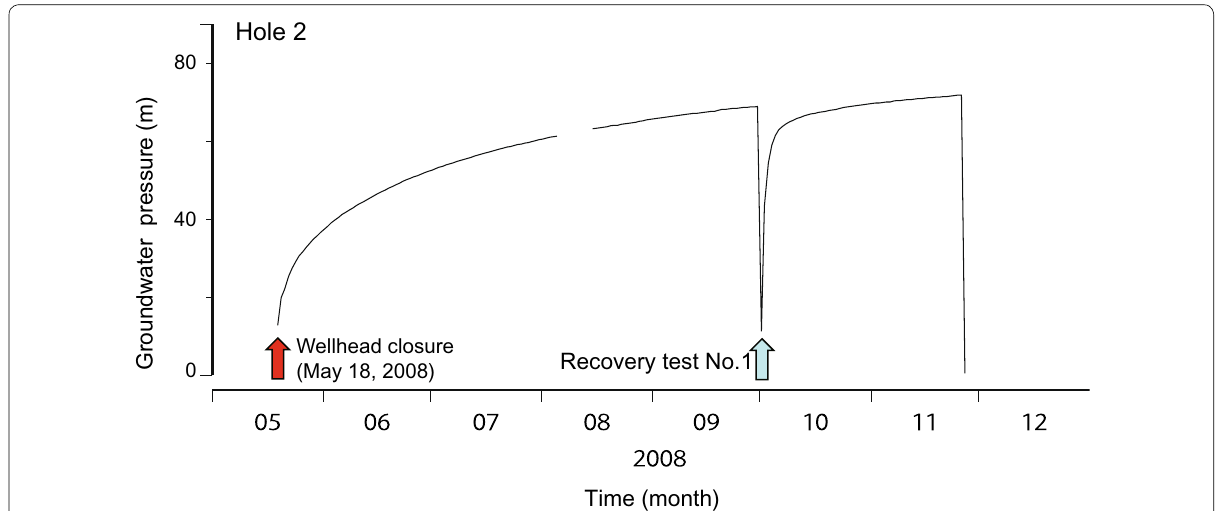
Fig. 5 Daily groundwater pressure data from 2008 at Hole 2. The red arrow shows when the wellhead was closed to observe groundwater pressure. The blue arrow shows when the wellhead was temporarily opened and a recovery test was performed after closure